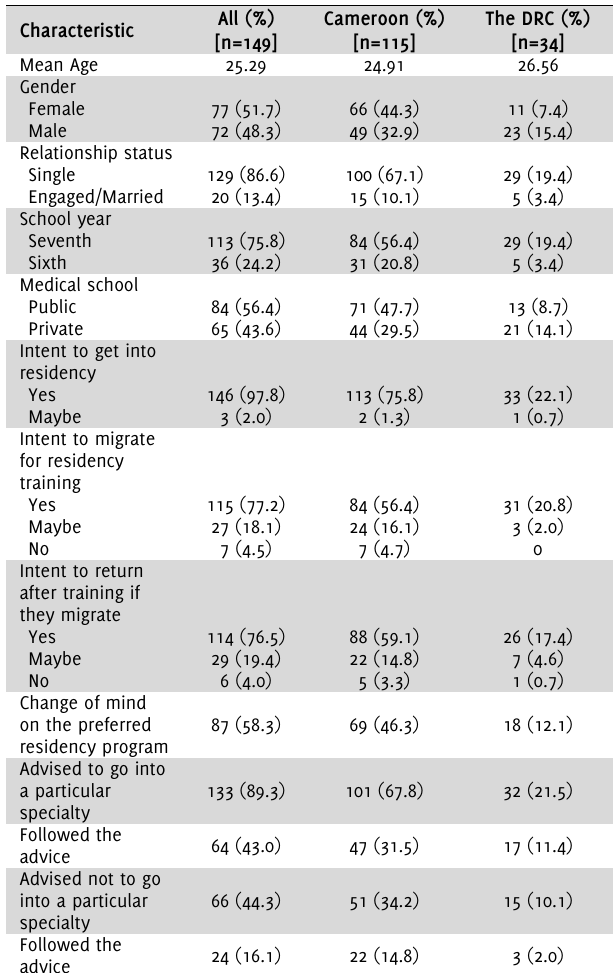
Table 1 . Cameroonian and Congolese Medical Students’ Sociodemographic Characteristics, Intention to Specialize and Intention to Migrate in Online Survey by Frequency and Percentage.